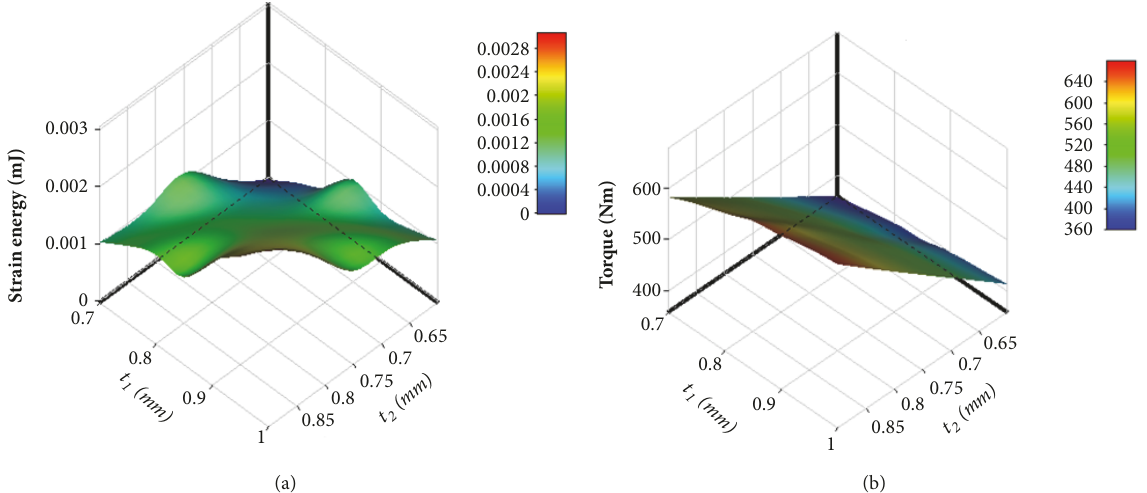
Figure 11: Effect diagram of t